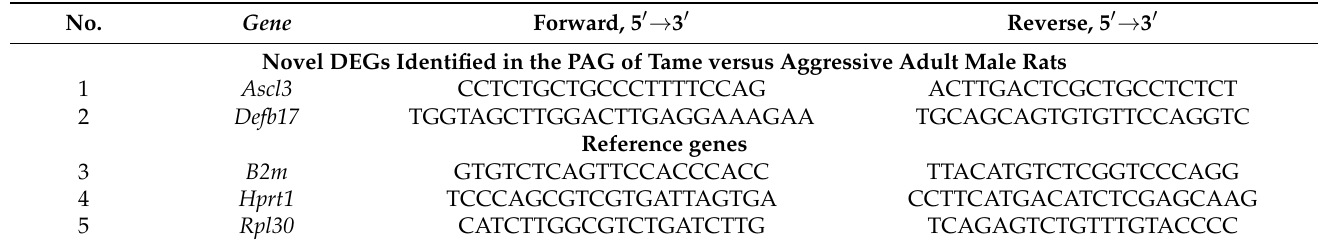
Table 11. qPCR primers selected via the publicly available web service PrimerBLAST